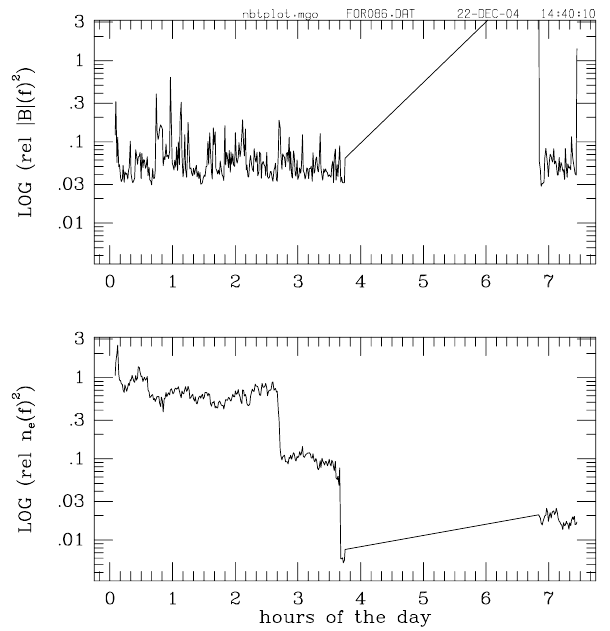
Fig. 7. Time series of relative power in magnetic and density fluc- tuations.